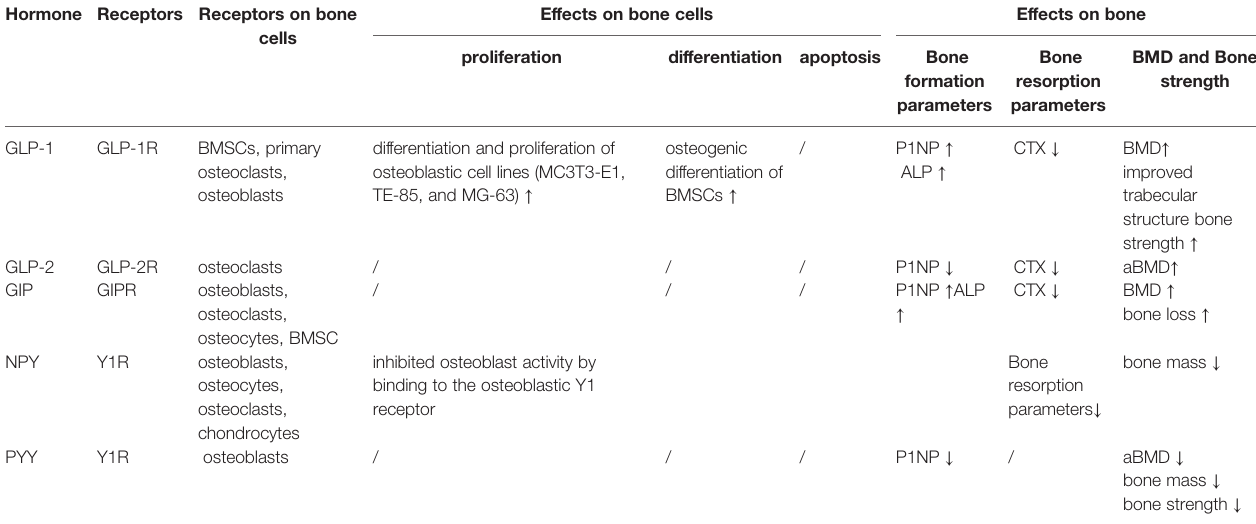
The symbols ↑ means elevation. The symbols ↓ means